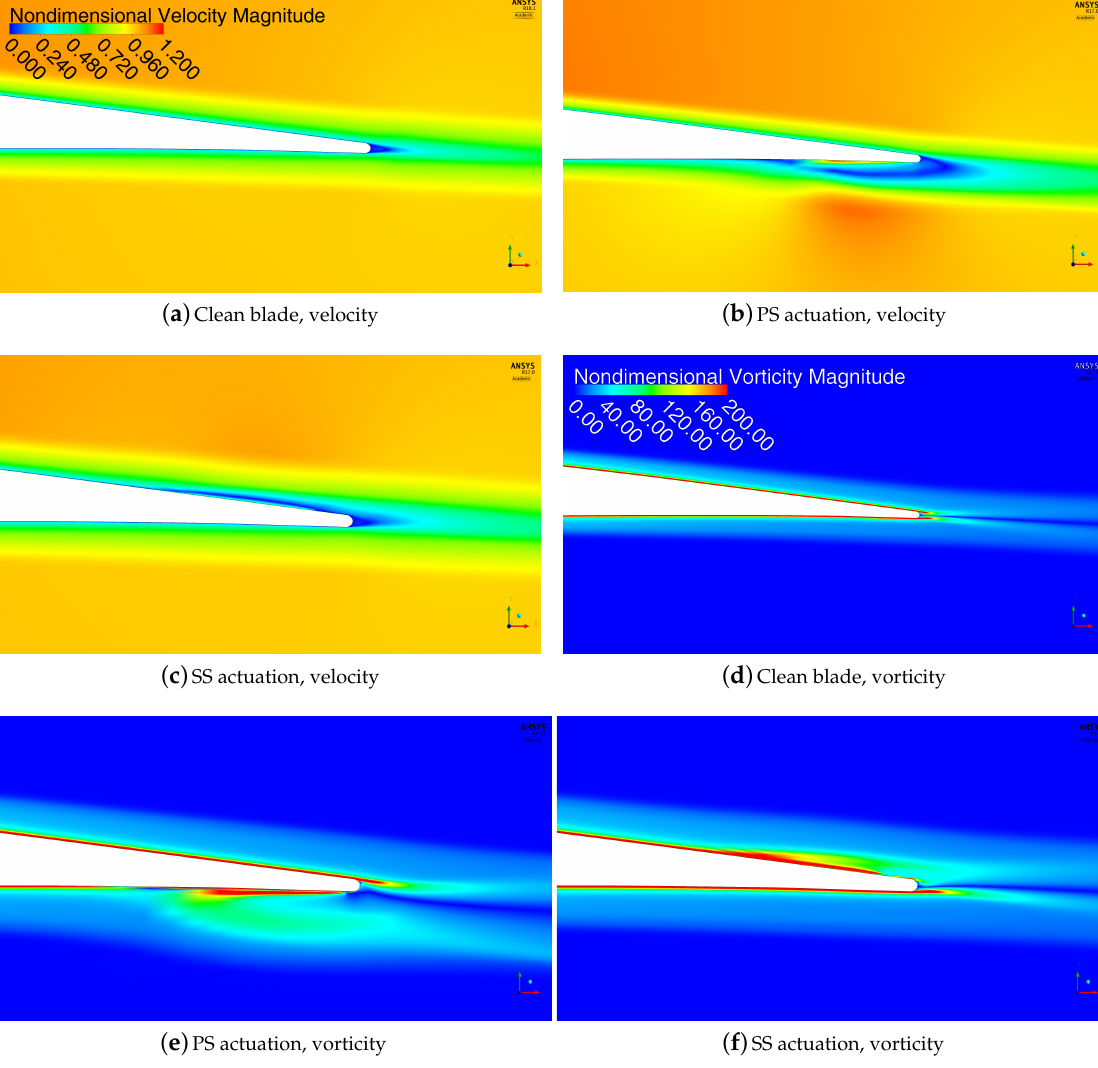
Figure 8. Trailing edge detail of velocity magnitude, normalized by the freestream velocity, and of z-vorticity magnitude, normalized by the chord/freestream velocity ratio, for the clean cascade and with PS/SS actuation; Re ∼ 350,000; α = 2